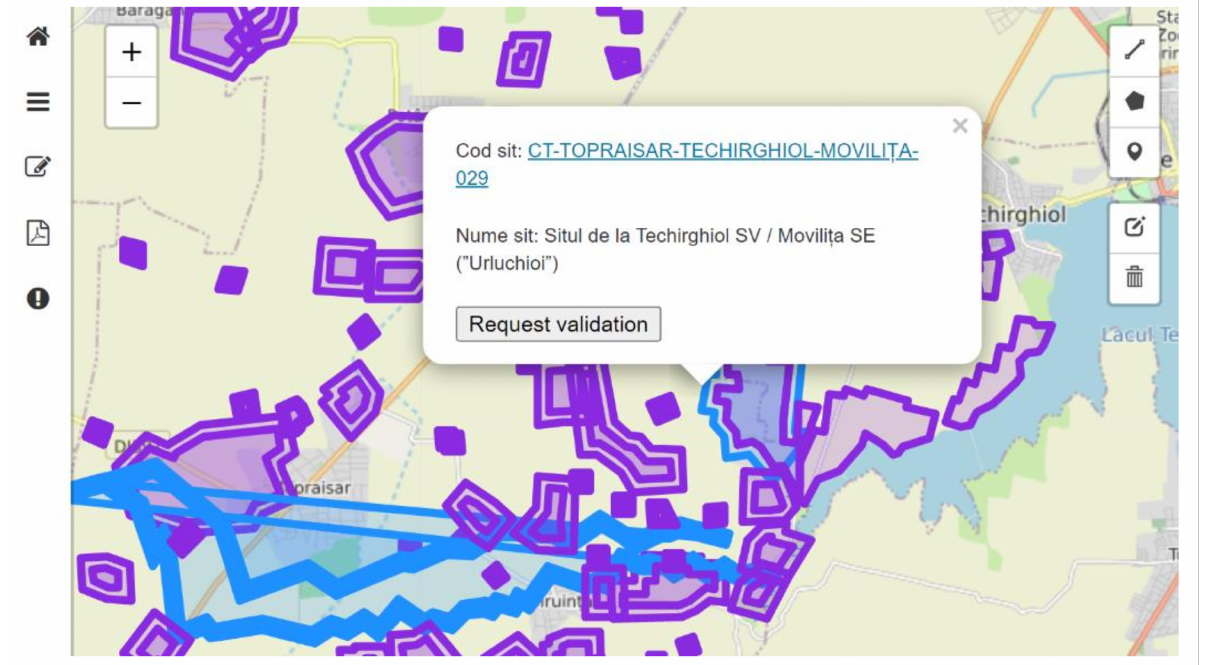
Figure 15. Archeological site protected areas sent for validation (blue) and already validated